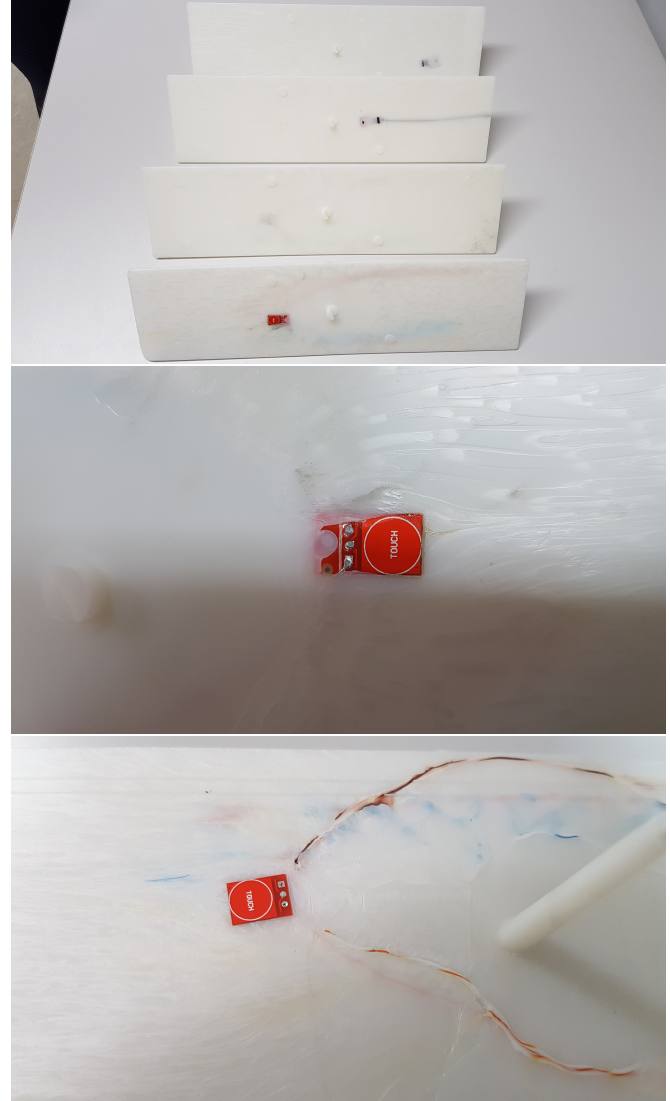
Figure 17. The figure illustrates the tests that were performed by over-moulding embedded sensors in different types of polymers. The tests were conducted for senor 2. Although most of the sensors were functional after moulding, they were subject to high pressure and temperature, which may have consequences related to the robustness and durability of the component during use over time. This the main reason why this path of investigation has been left for future